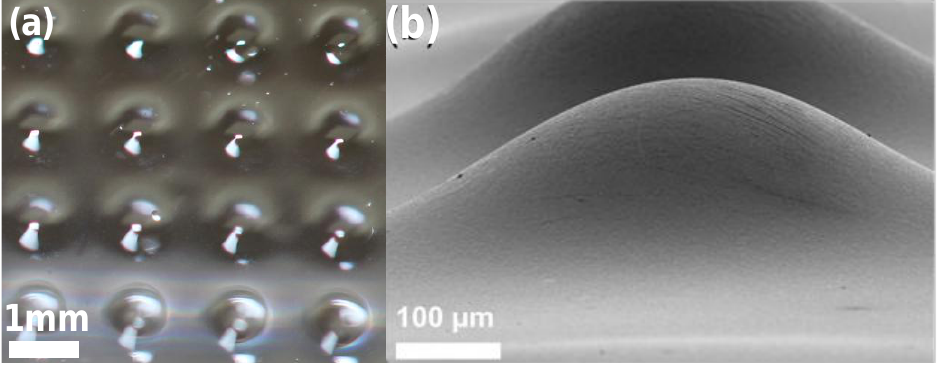
Figure 1. ( a ) Optical image of a 0.7-mm microlens array. ( b ) Scanning electron microscopy image of 0.7-mm